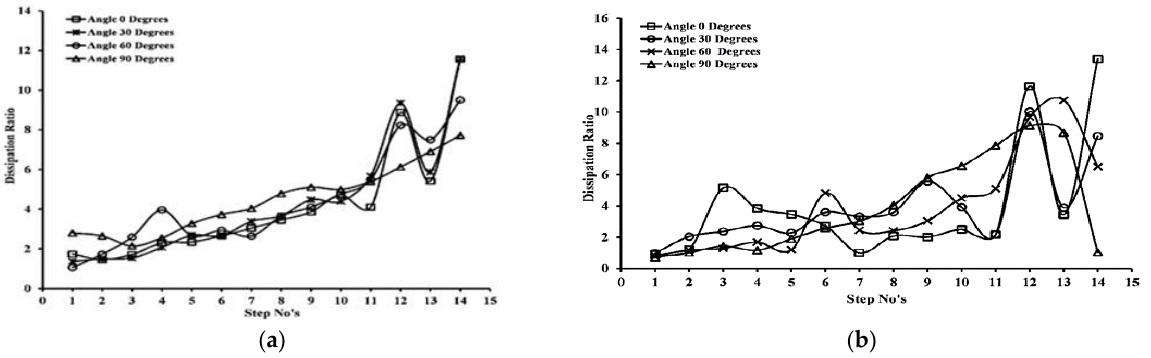
Figure 15. ( a ). EDD for the Q = 0.0208 m 3 /s. ( b ). EDD for the Q = 0.027 m 3 /s.